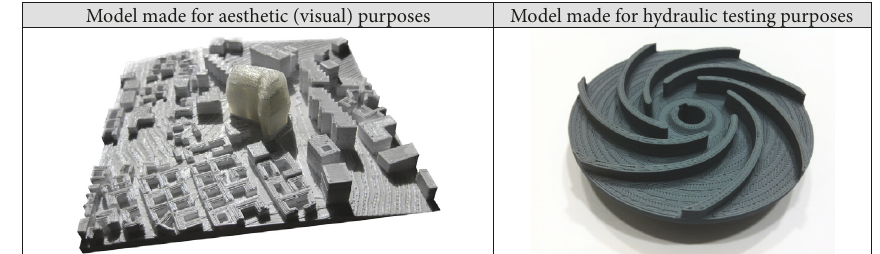
Figure 6: Function prototypes for